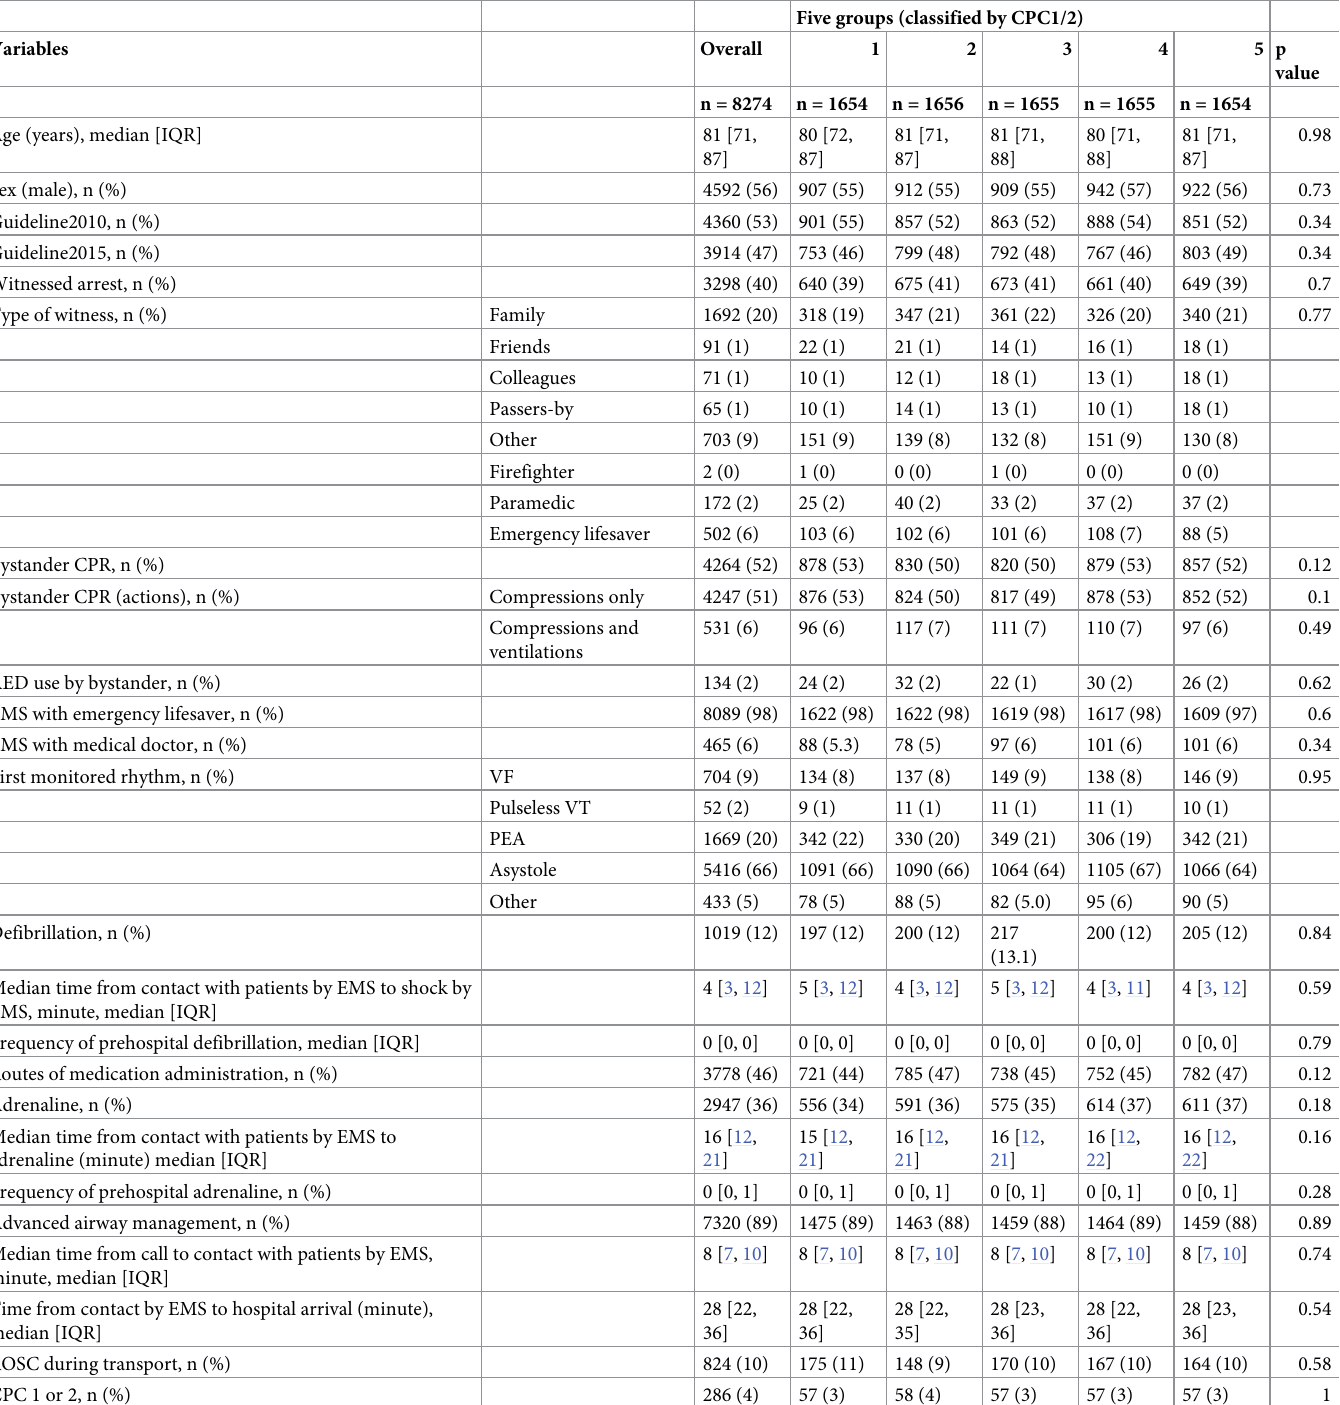
Table 1. Overall patient background and comparison between five groups classified by